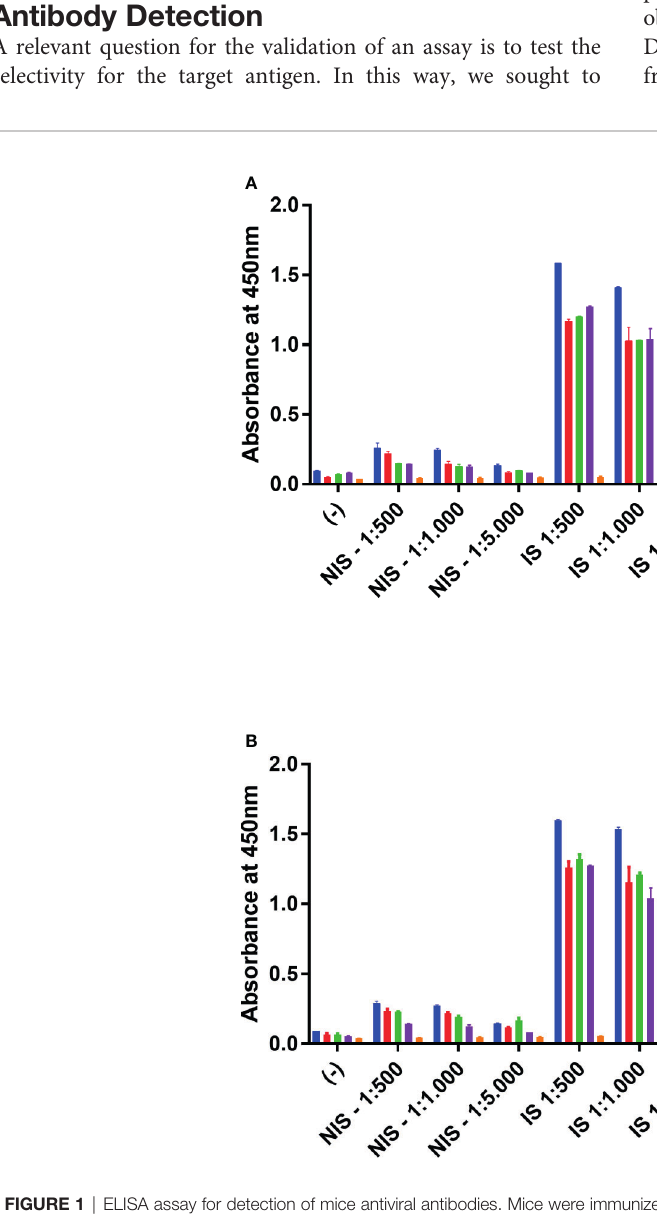
FIGURE 1 | ELISA assay for detection of mice antiviral antibodies. Mice were immunized with inactivated SARS-CoV-2 virus, and serum samples were collected with 14 days. (A) Plates were coated with 1.0 mg/ml of indicated viral antigens or 1:250 of inactivated virus. (B) plates were adsorbed with 100 ng/ml of indicated viral antigens or 1:250 of inactivated virus. Target antigens: prot.N (N protein), prot.3CL (3CL protein), prot.S (S protein), inactivated virus 1:250 (inactivated virus diluted 1:250), PBS 1x (1X PBS diluent as negative control). Two-way ANOVA, p < 0.05 for IS against NIS for all target antigens, but PBS 1x, in all dilutions. Representative experiment of two independent experiments. The serum of fi ve animals was pooled for each